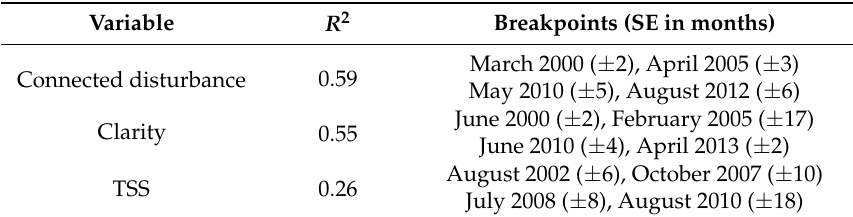
Table 3. Piecewise regression output.